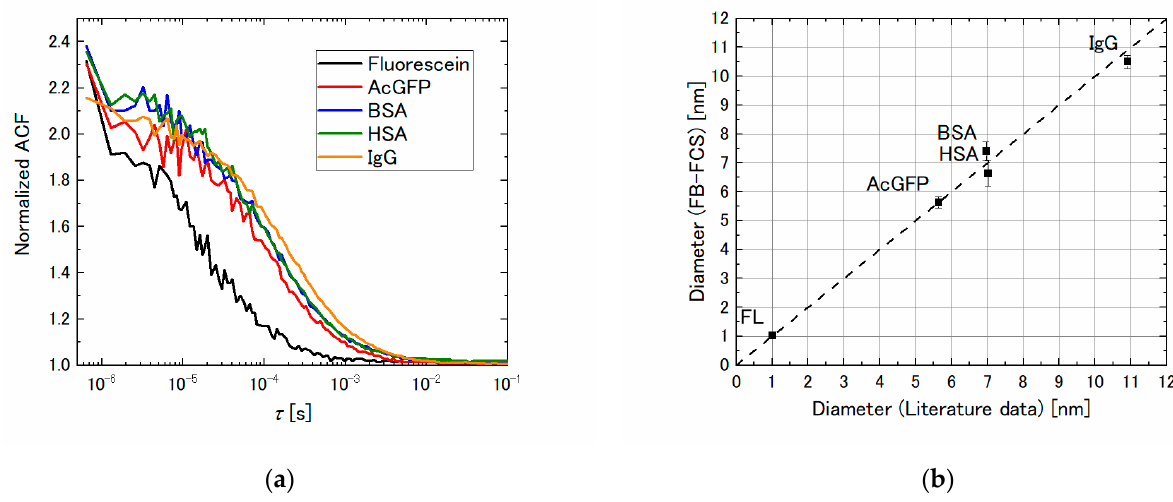
Figure 3. FB-FCS measurements on fluorescently labeled proteins. ( a ) Normalized ACFs. ( b ) Comparison between diameters measured by FB-FCS and results from the literature. The dashed line shows the y = x line. The error bar represents the standard error ( n = 5–8). FL denotes the data point of fluorescein.